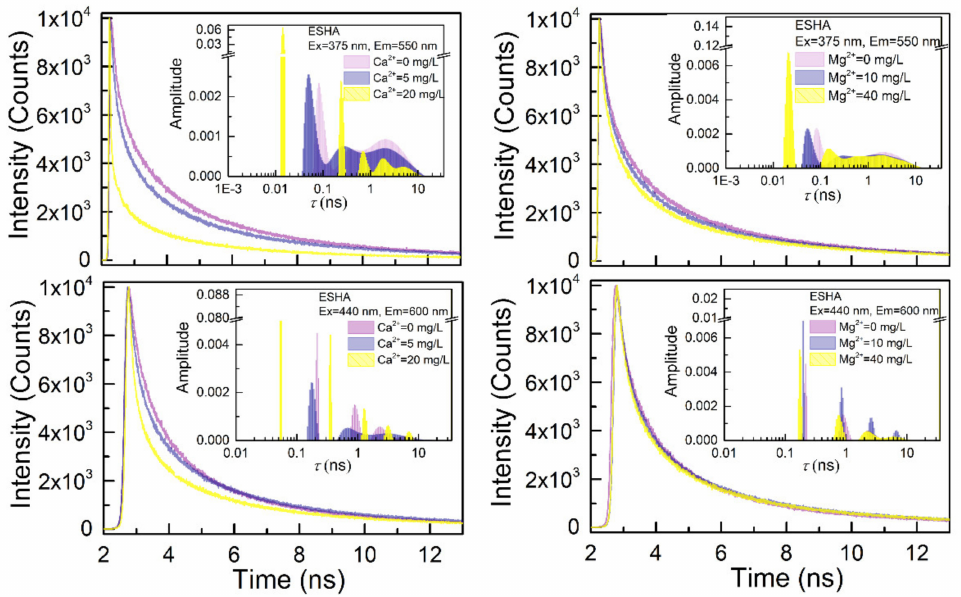
Figure 6. Effects of Mg 2+ and Ca 2+ concentrations on the lifetime distributions for emission decay of ESHA (10 mg C/L) aqueous solution at excitation of 375 and 440